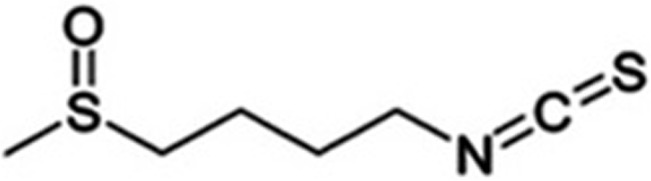
Chemical structure of sulforaphane (SFN).